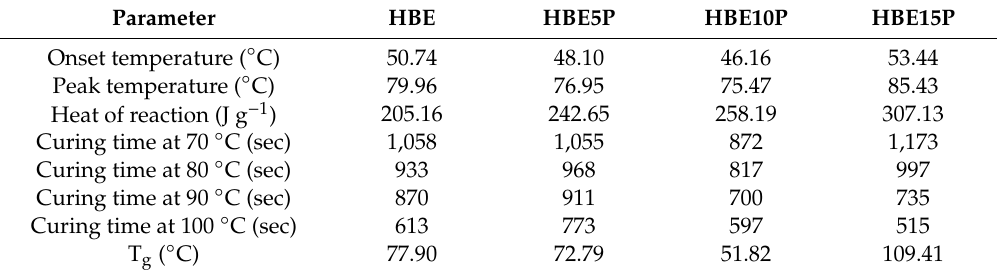
Table 3. The curing behavior and thermal properties of HBE, HBE5P, HBE10P, and HBE15P.